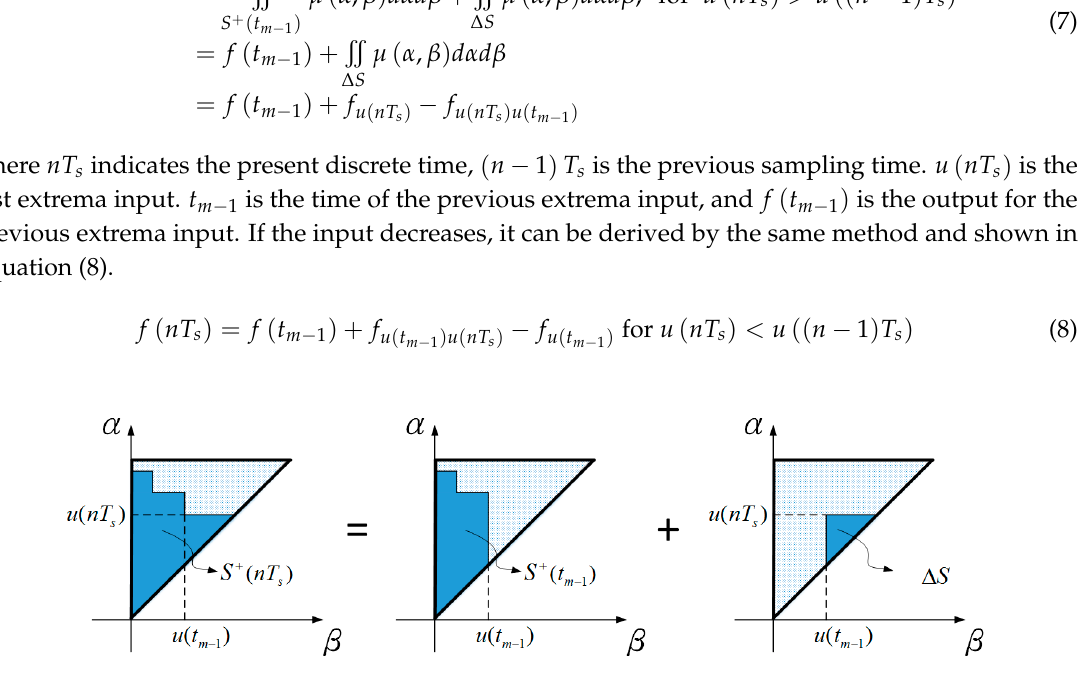
Figure 8. The relationship between input signals and the processing of the Preisach plane.